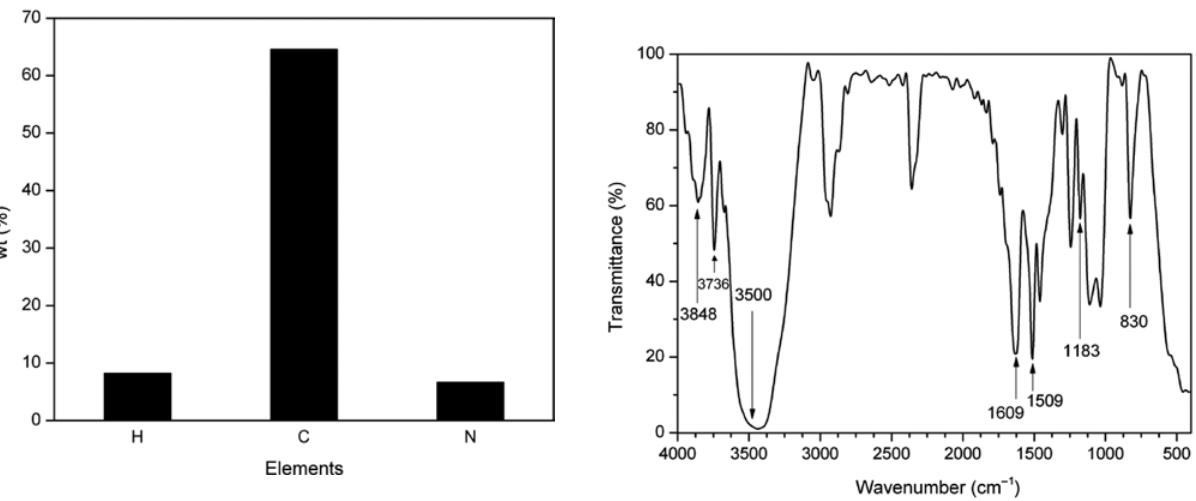
Figure 4: The IR spectrum of the cured epoxy